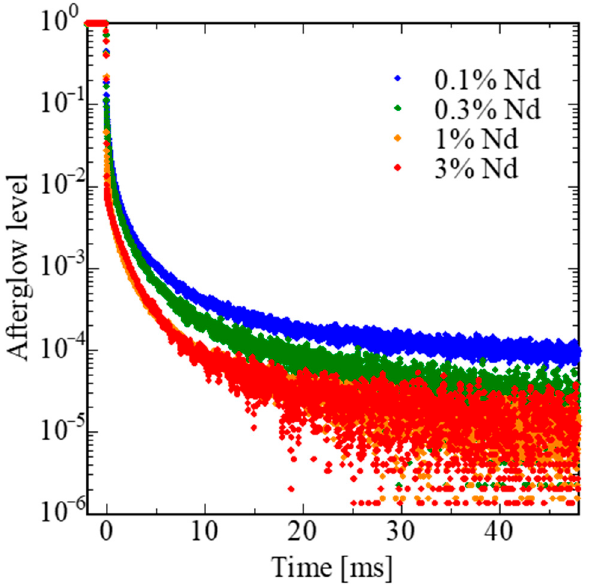
Figure 7. Afterglow curves of LaMgAl 11 O 19 :Nd after 2 ms X-ray irradiation.